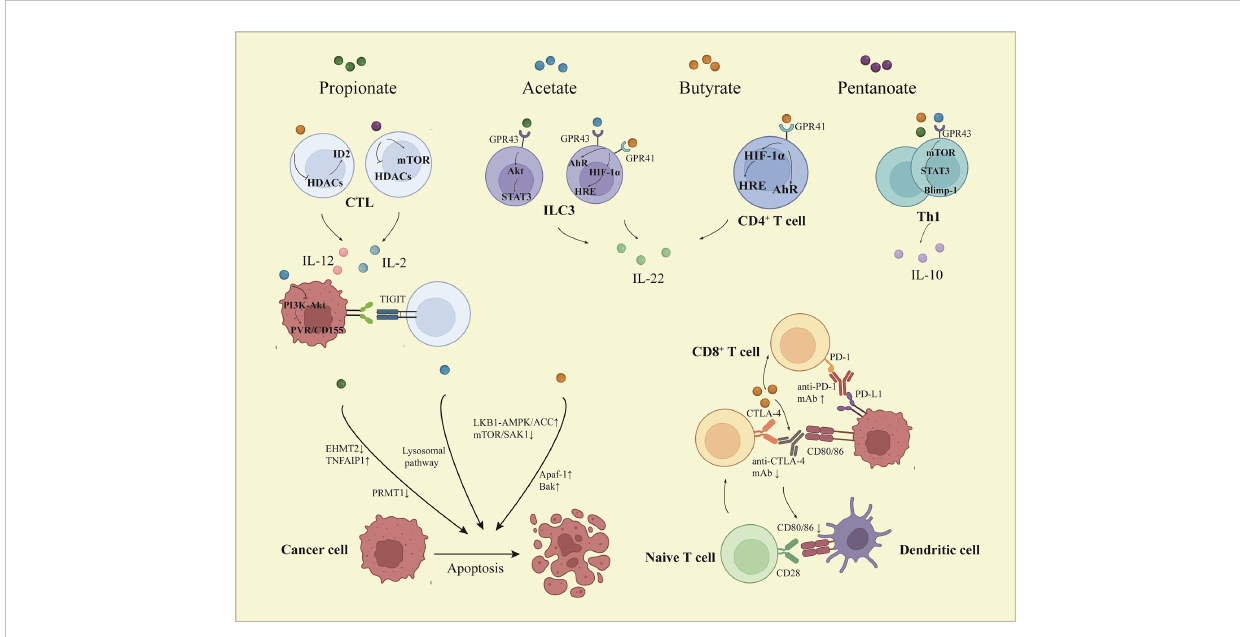
FIGURE 2 The effects of short chain fatty acids on tumor immune microenvironment. Depending on activation of STAT3 and mTOR, SCFAs promote Th1 cell expression of Blimp-1, which increases IL-10 expression. Butyrate and pentanoate promote the expression of IL-12 and IL-2 respectively in CD8+ T cells via HDACs inhibitory activity. Acetate decreases the expression of PVR/CD155 through inactivation of PI3K/AKT pathway, thus enhancing the response of CD8+ T cells. SCFAs induce IL-22 production in CD4+ T cells and ILCs, which is mediated by HIF-1 a and AhR or involved by Stat3 and mTOR. Butyrate facilitates the anti-PD-1 mAb ef fi cacy via regulating the T cell in fi ltration, while butyrate reduces ef fi cacy of CTLA-4 blockade and limits DC maturation. Furthermore, SCFAs induce apoptosis of cancer cells through multiple ways. STAT3, signal transducer and activator of transcription 3; mTOR, mammalian target of rapamycin; Blimp-1, B lymphocyte-induced maturation protein 1; PI3K, phosphoinositide 3-kinase; AKT, the protein kinase B; PVR, poliovirus receptor; HRE, hypoxia response element; AhR, aryl hydrocarbon receptor; HIF-1 a , hypoxia inducible factor-1 a ; IL, interleukin; Th, T helper; CTL, cytotoxic T lymphocyte; ILC, innate lymphocyte